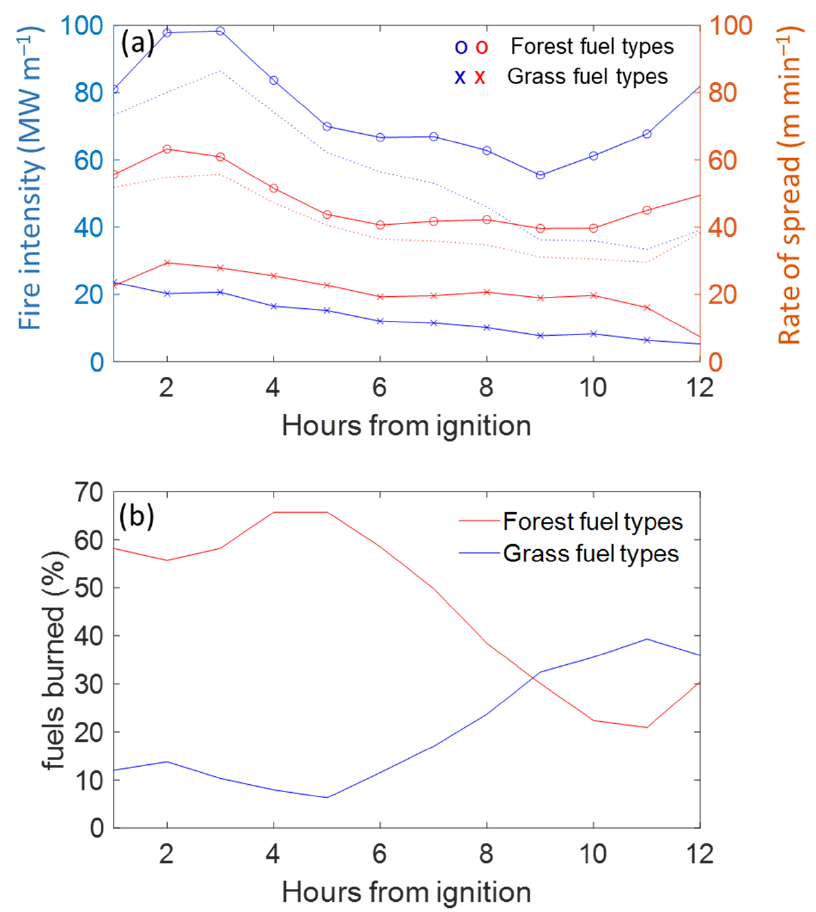
Figure 4. Simulated hourly ( a ) fire intensity (blue) and rate of spread (red) of the 2018 Camp Fire, and ( b ) proportion of area burned per hour for forest compared to grass fuel types. Dashed lines in ( a ) indicate hourly averages for all fuel types burned for the hour.